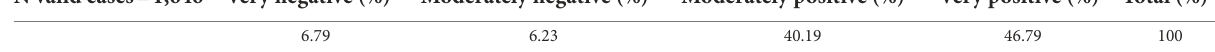
TABLE 2 Sentiment analysis of intrinsic motivation dimension. N valid cases = 1,646 Very negative (%)